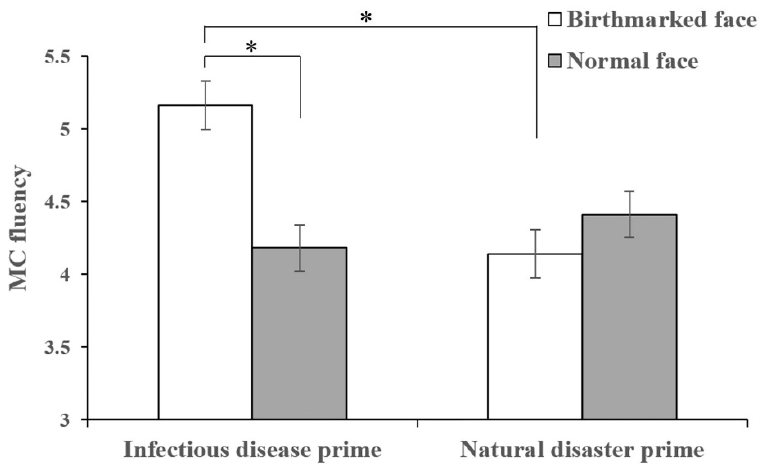
Figure 2. The influence of the interaction between threat prime and disease-connoting cue on MC fluency (displayed ± SE ). * p < 0.05.